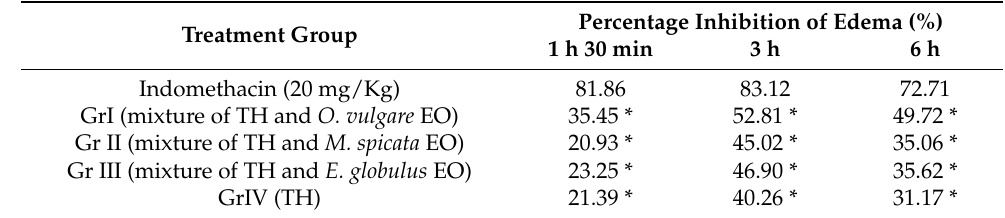
Table 9. Percentage inflammation inhibition by Thyme honey and mixtures on experimental trauma ‐ induced rat paw edema.